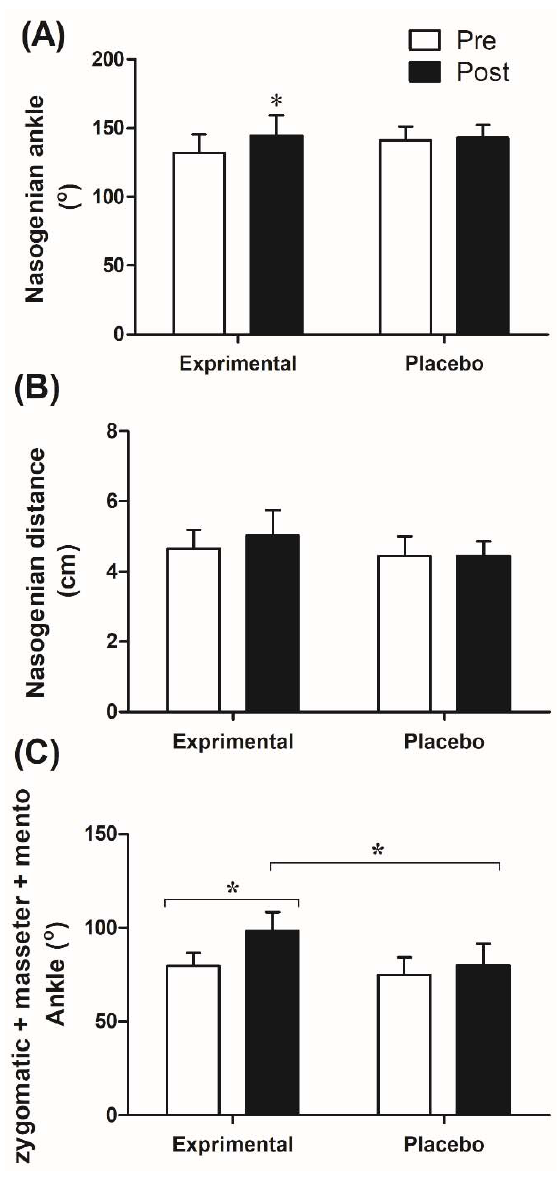
Figure 4. Nasogenian sulcus angle ( A ), nasogenian sulcus distance ( B ) and zygomatic + masseter + mento ankle ( C ). Data are mean and standard error (SE). * p < 0.01 compared to preintervention and control groups.